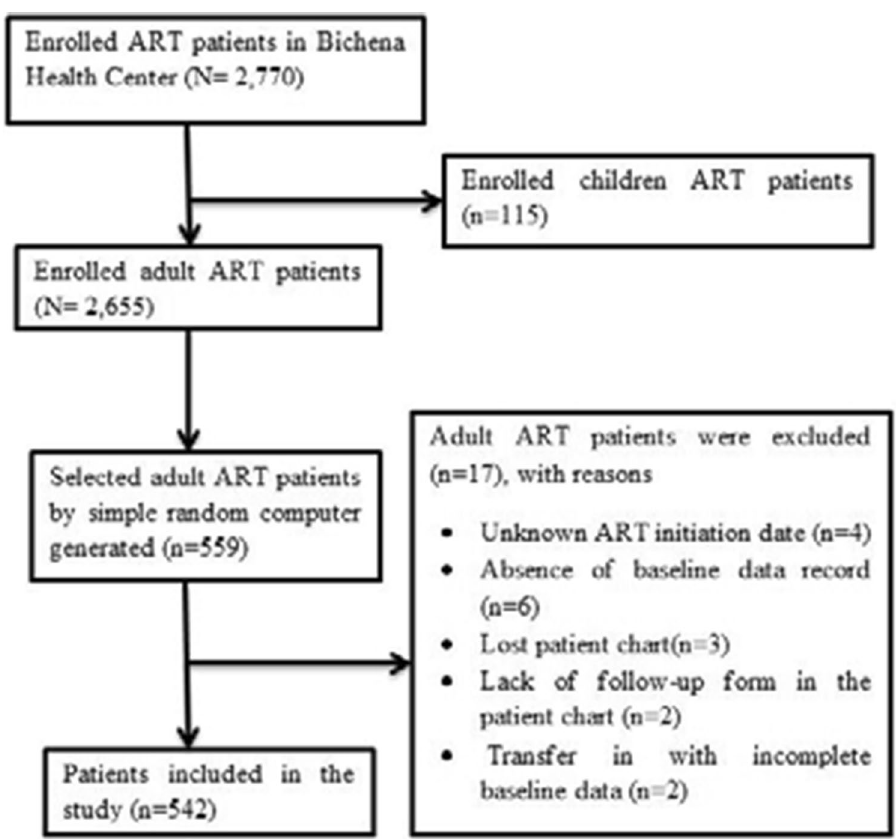
Figure 4. A flow chart to show the selection of study participants among HIV patients in Bichena health center, Amhara, January 1, 2008–December 30,